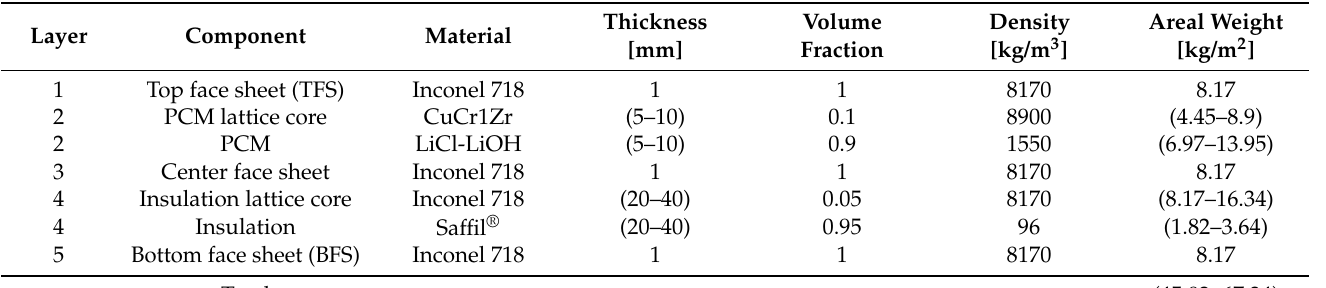
Table 4. Geometrical and physical properties of the lattice core-PCM ITPS layers, with reference to the schematic in Figure 6.